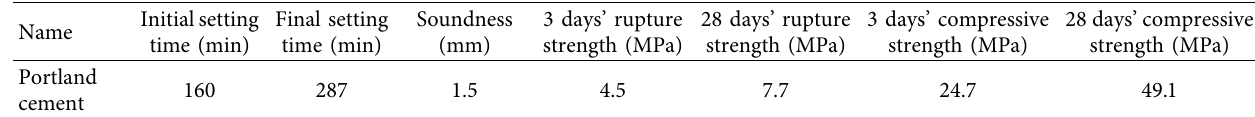
Table 4: Portland cement